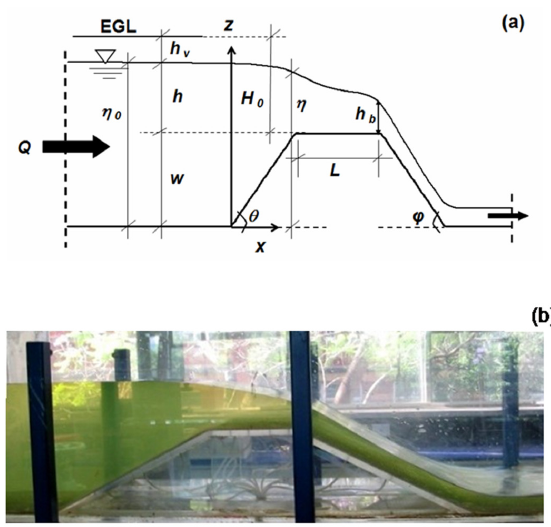
Figure 1. ( a ) Definition sketch for weir flow; and ( b ) transcritical flow over a trapezoidal short-crested weir, after Zerihun [2]. The overflow depth, brink depth and height of the weir crest are denoted by h , h b and w , respectively, and EGL stands for the energy grade line. The Cartesian coordinates ( x , z ) are also shown.